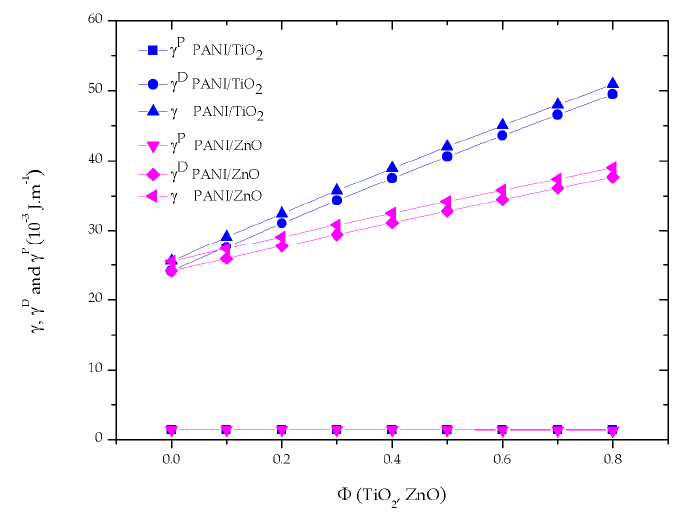
Figure 5. Surface energy of PANI/TiO 2 and PANI/ZnO as a function of Φ of NPs.